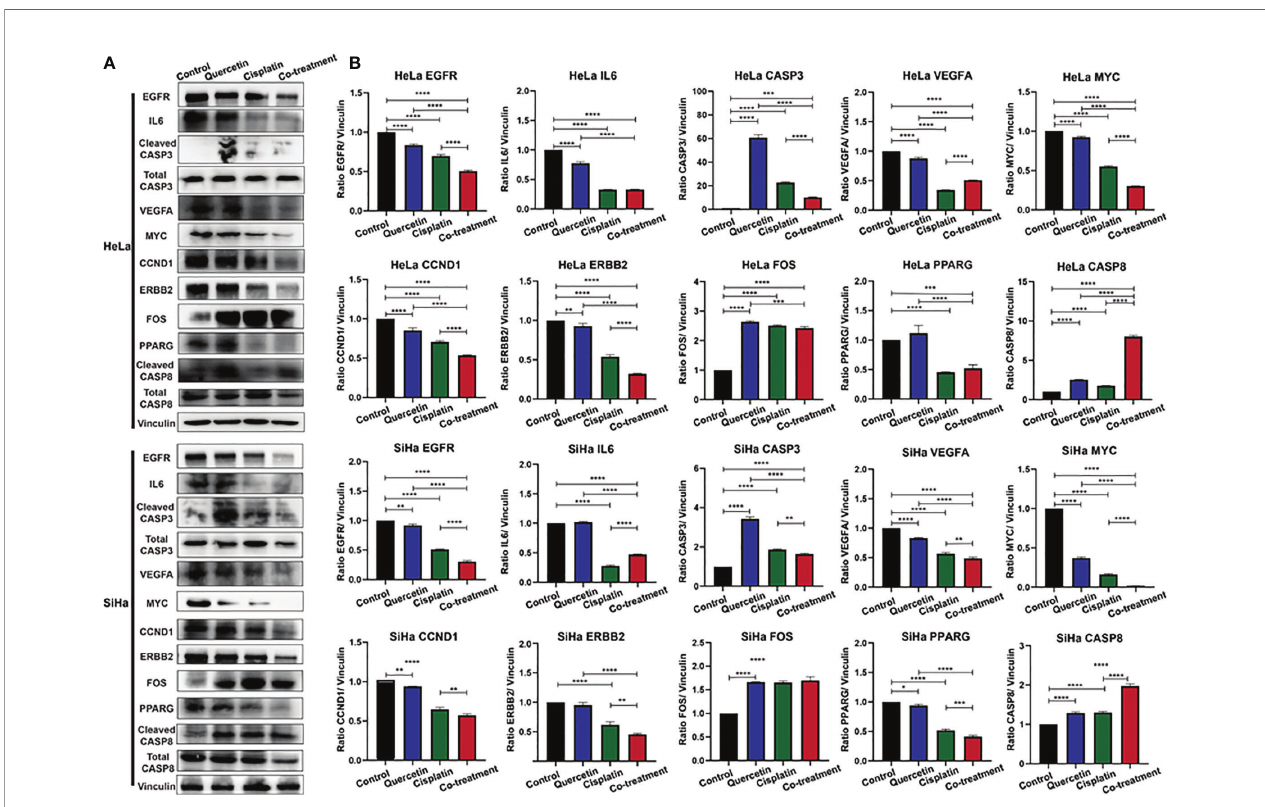
FIGURE 7 | Western blotting was used to detect the relationship between the target protein and cervical cancer. (A) Immunoblot of EGFR, IL6, CASP3, VEGFA, MYC, CCND1, ERBB2, FOS, PPARG, and CASP8 in HeLa cells and SiHa cells. Vinculin was used as a loading control. (B) Densitometry for quantitation of relative differences in band intensity for of EGFR, IL6, CASP3, VEGFA, MYC, CCND1, ERBB2, FOS, PPARG, and CASP8 normalized to vinculin in (A) . * P < 0.05, ** P < 0.01, *** P < 0.001, **** P <